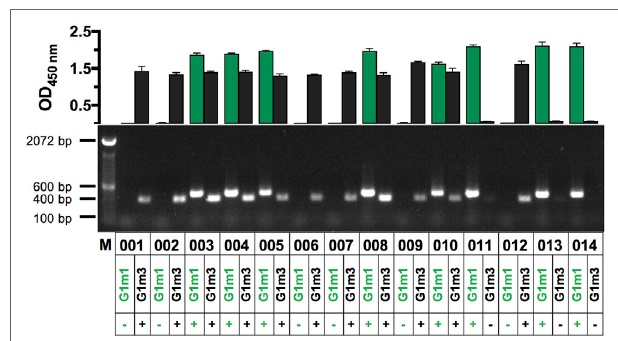
FigUre 1 | Assessment of IgG1-allotypes G1m3 and G1m1 in a cohort of HIV vaccine recipients via PCR and ELISA ( n = 14). In the top chart OD-values for G1m3-specific signals (black bars) and G1m1-specific signals (green bars) are shown for X001 study participants (labeled 001–014). Shown are the mean ( ± SD) OD 450 -values of technical triplicates, representative of three replicates. OD-values greater than 0.5 were considered to be positive for the respective IgG1-allotype G1m3 and/or G1m1. The bottom panel shows the corresponding results from a novel PCR protocol, which was used to determine IgG1-allotypes from human RNA. Band sizes are 400 bp for G1m3 and 463 bp for G1m1 as indicated by the marker on the